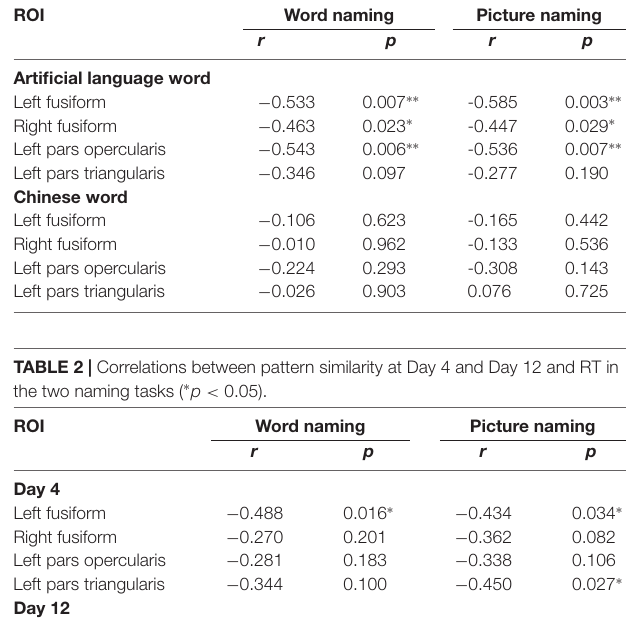
TABLE 1 | Correlations between pattern similarity before training and reaction time (RT) in the two naming tasks ( ∗ p < 0.05 and ∗∗ p < 0.01). ROI Word naming Picture naming r